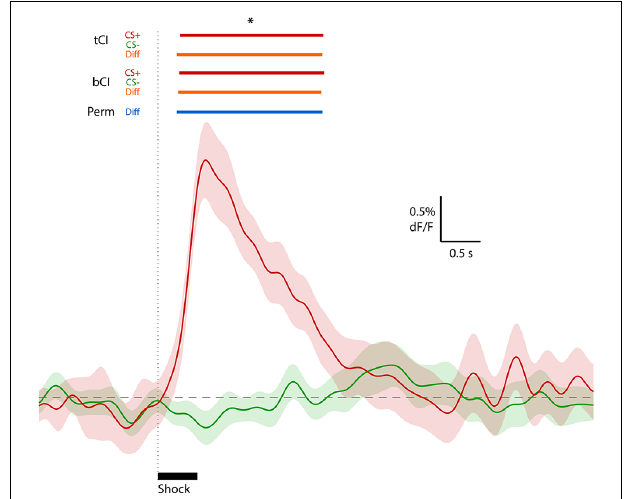
FIGURE 4 | Waveform analysis of real peri-shock (CS+; red waveform) and control (CS − ; green waveform) data depicted in Figure 1 (from Sengupta et al., 2018; Figure 1C). An excitatory ERT following shock onset for CS+ (red bars above graph), but no ERT for the CS − comparison, was identified using t interval (tCI) and bCI. A significant difference between CS+ and CS − (two-sample comparison) was also determined using these CI methods (orange bars above graph) and permutation tests (blue bar above graph). ∗ Significant at 95% confidence level (full low-pass consecutive